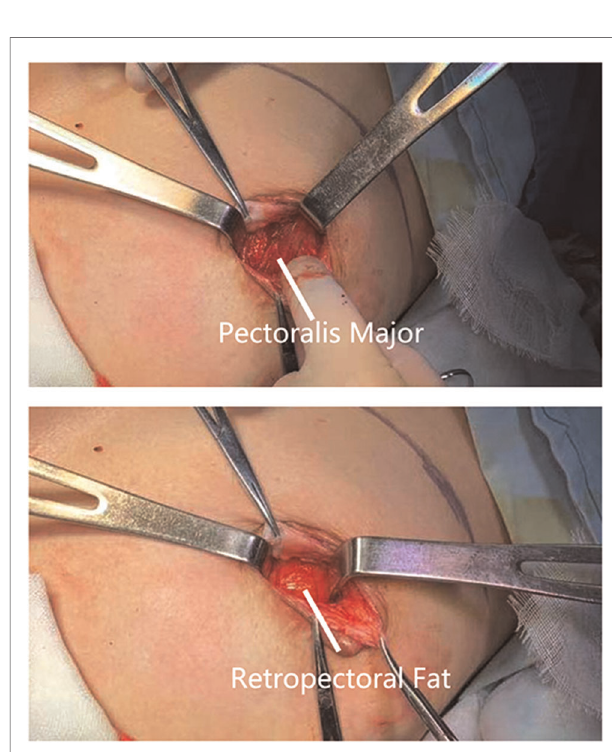
FIGURE 5 | Collection of fat specimen during an implant-based breast augmentation 6 months after fat grafting. During the surgery, the transplanted fat tissue was clearly observed beneath the pectoralis major